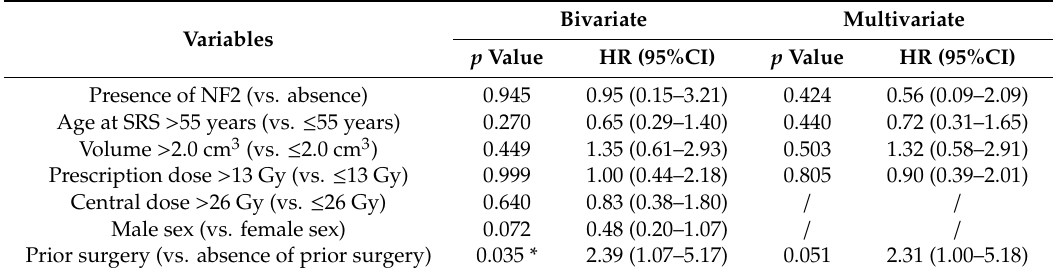
Prior surgery (vs. absence of prior